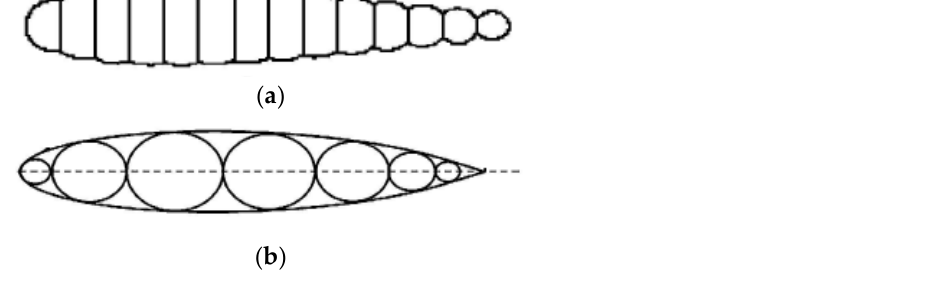
Figure 1. Sketch of the airfoil for an inflatable wing. ( a ) Multi-beam wing section. ( b ) Multi-tube wing section.